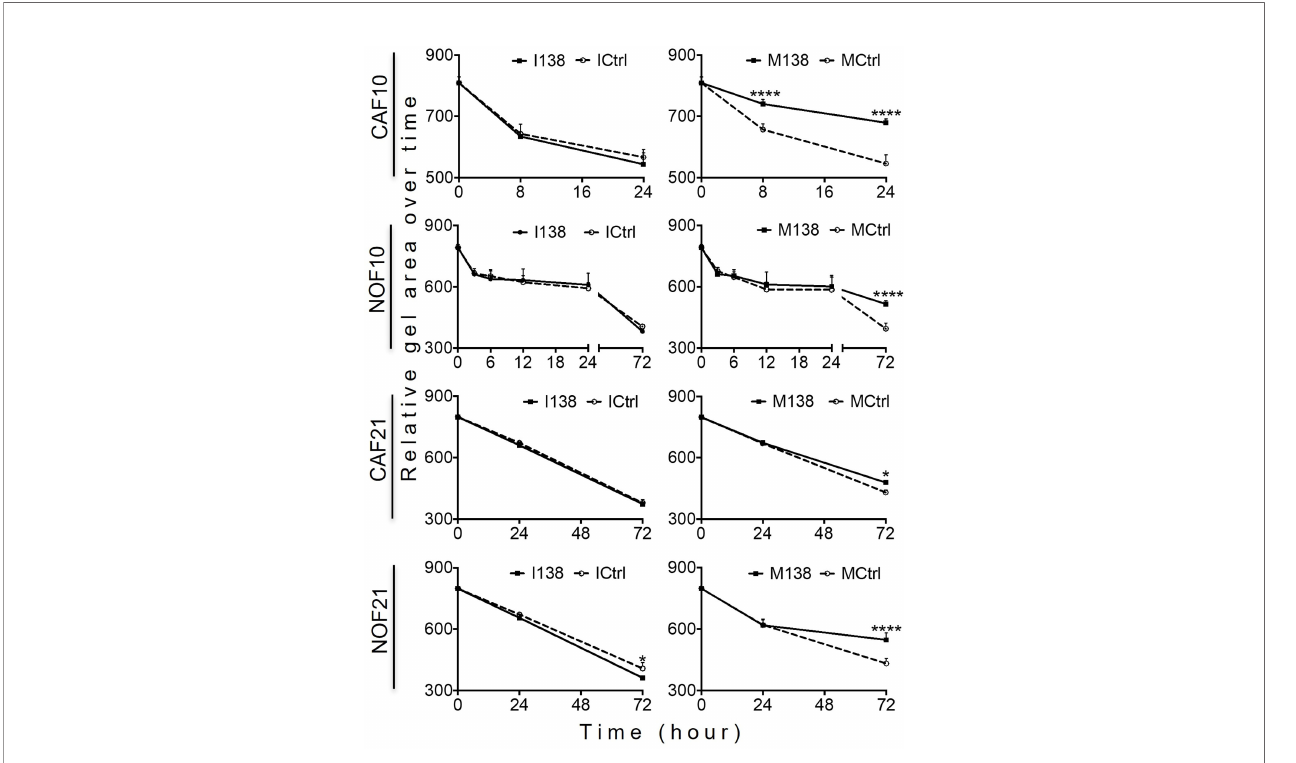
FIGURE 6 | Altered miR-138 expression modulates the ability of fi broblasts to contract collagen gels: Collagen I contraction by CAFs and NOFs over time. n = 4 – 6; one-way ANOVA; mean ± SD; * p < 0.05, **** p < 0.0001.